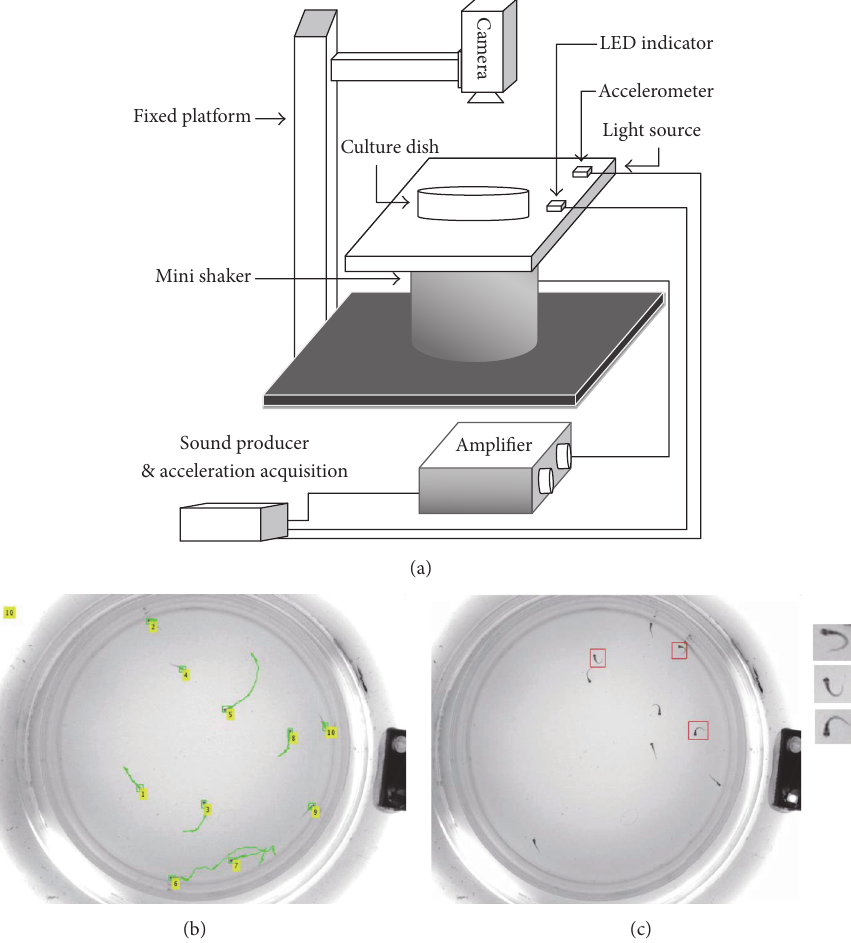
Figure1:Recordingthestartleresponseinzebrafish.(a)Instrumentationforthemeasurementofstartleresponse.(b)Movingtracesidentified from multiple picture frames after delivering a stimulus. (c) Characteristic C-bend motion identified in a single picture frame from a subset of